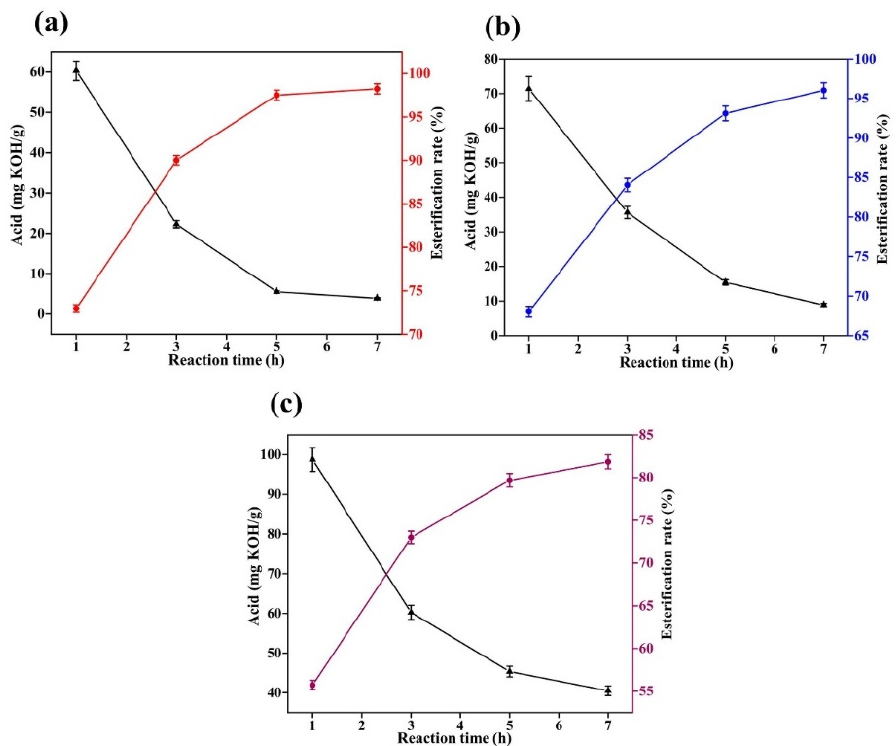
Figure 7. Results of catalytic esterification with different catalysts at 180 °C: ( a ): concentrated sulfuric acid; ( b ): sodium hydroxide; and ( c ): sulfamic acid.